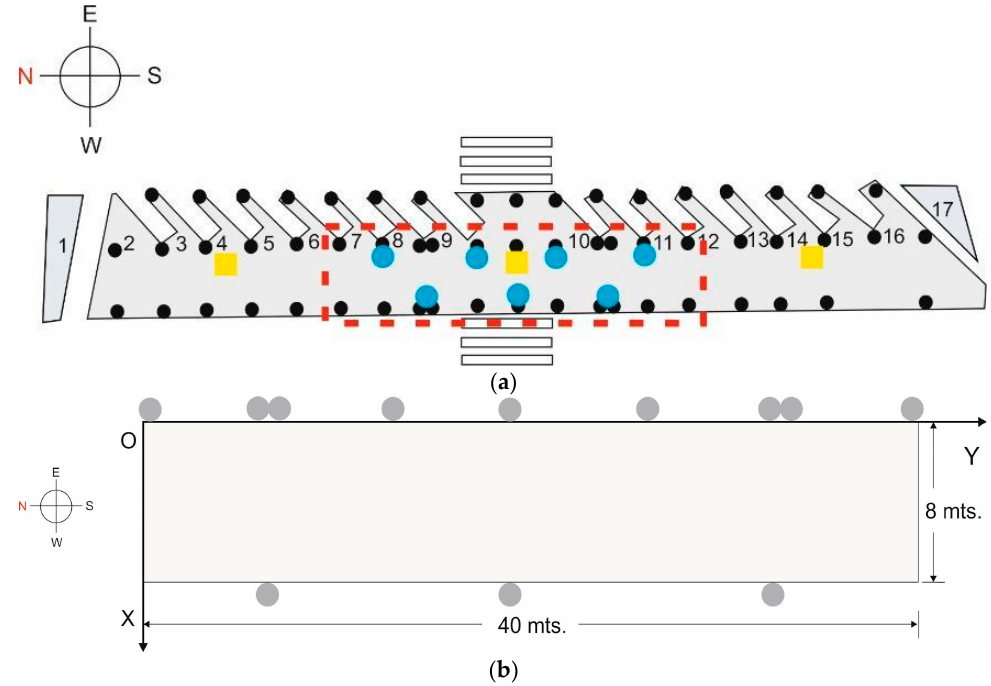
Figure 4. Testbed: ( a ) schematic view (highlighted in red); ( b ) dimensions and axes of chosen coordinates.